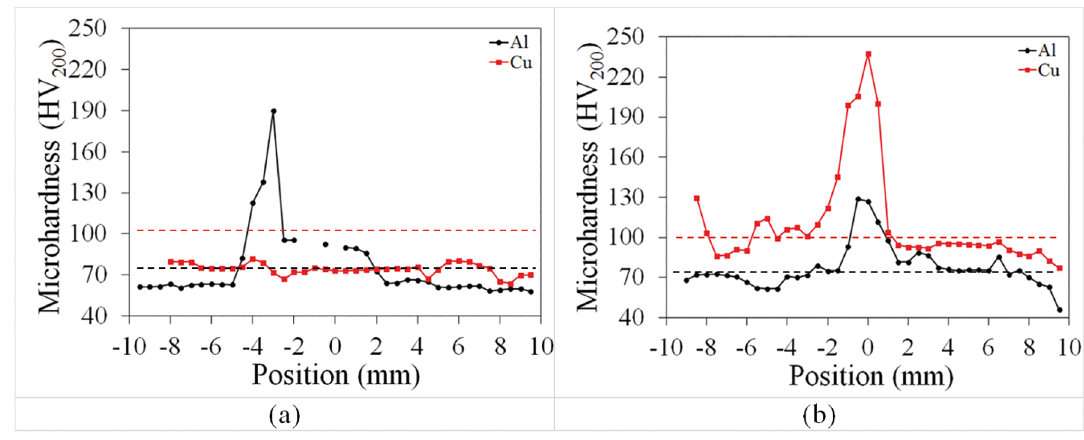
Figure 8. Microhardness profiles in cross section for WD 1100/10: (a) at IS (b) at FS positions.